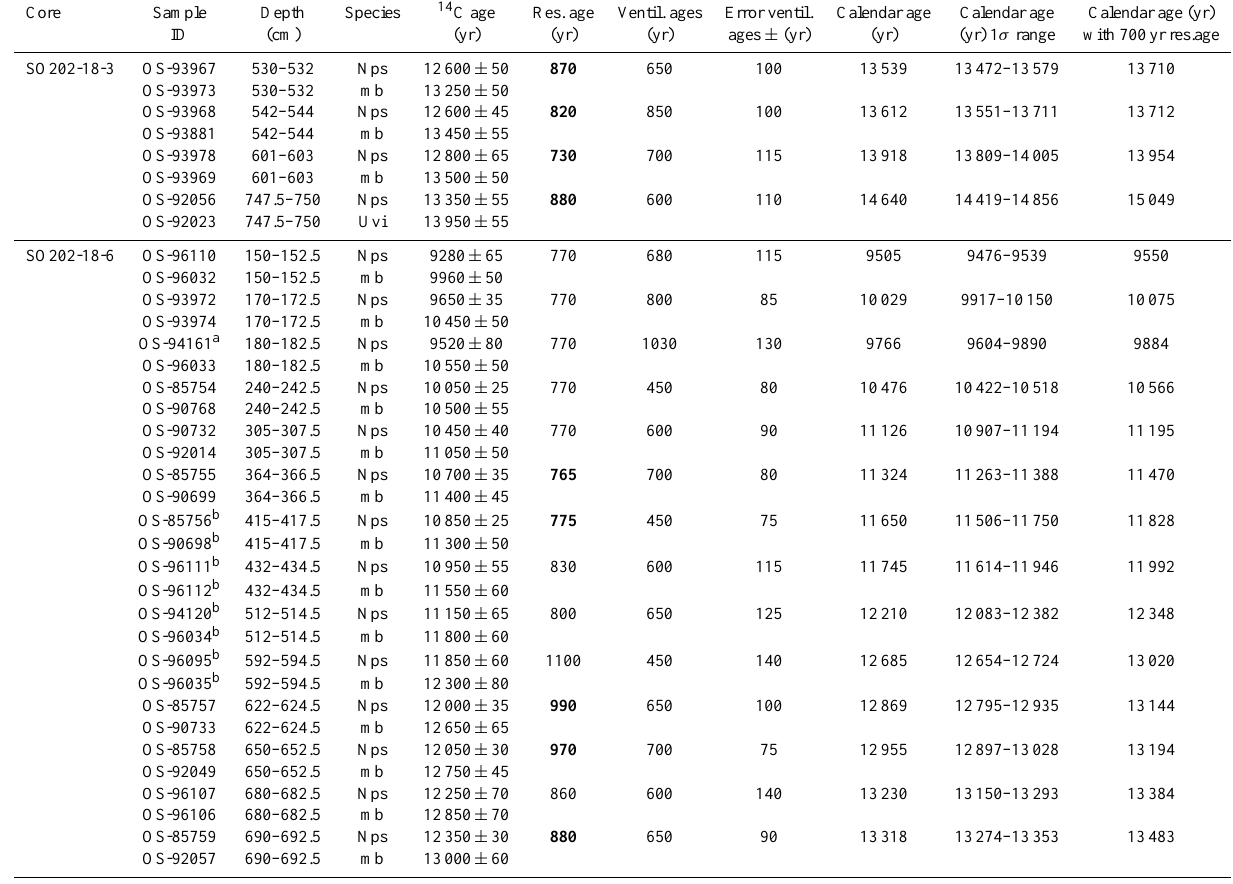
Table 2. AMS 14 C ages, calibrated calendar ages with 1 σ ranges, reservoir ages (res. age), and calculated benthic–planktic ventilation ages (ventil. age). Marked bold/italic res. ages are deduced by NGRIP correlation/layer counting. For comparison calendar ages with a constant reservoir age of R = 700yr are also shown. Nps: Neogloboquadrina pachyderma sinistral; Uvi: Uvigerina spp.; mb: mixed benthic